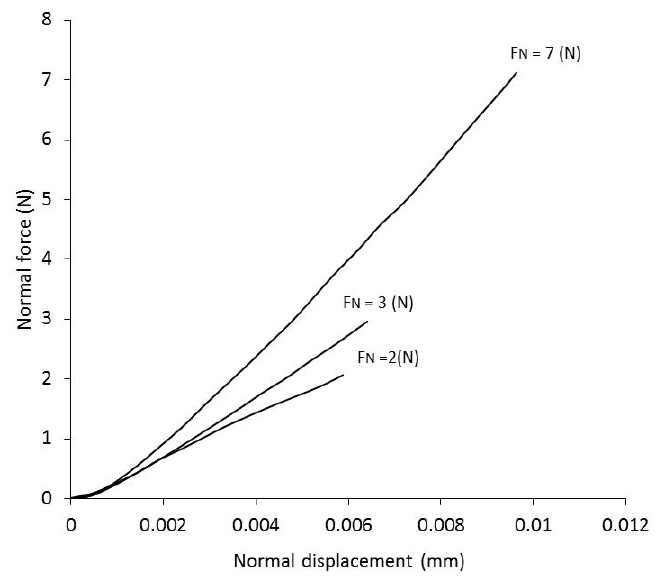
Figure 11. Typical plots of normal force–displacement at the contacts of LBS grains.